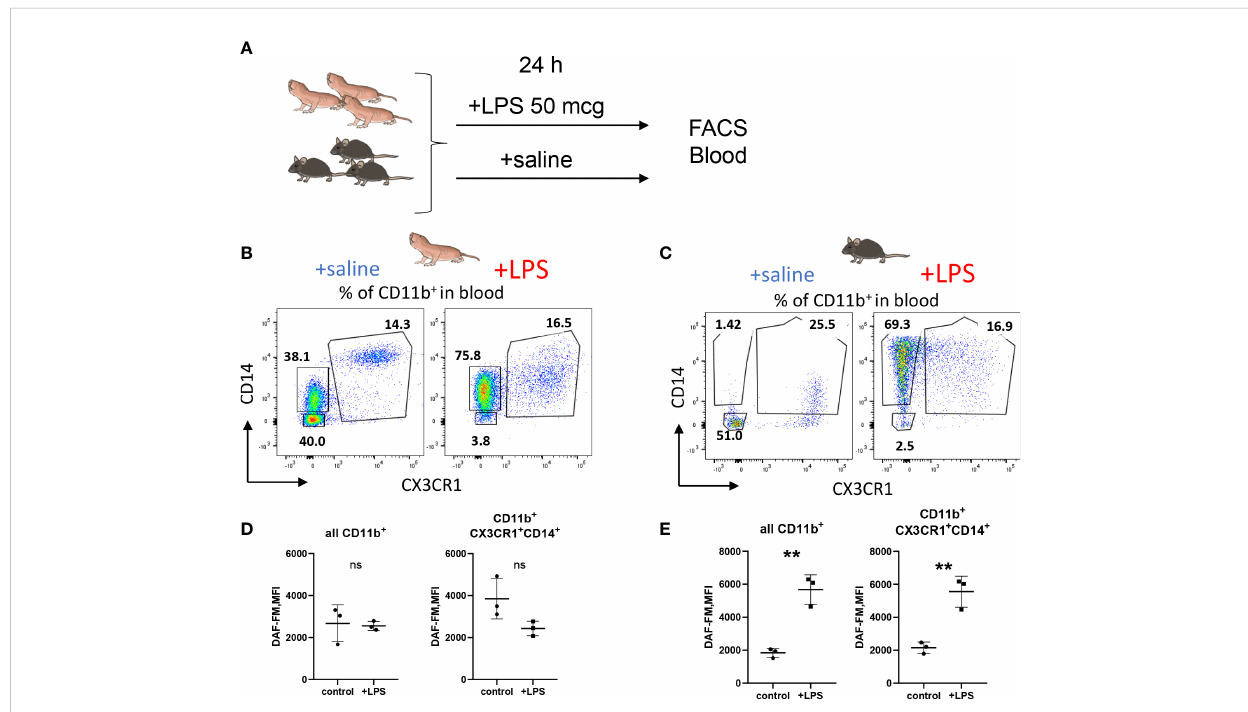
FIGURE 4 NO production is reduced in NMR myeloid cells after LPS administration in vivo. (A) Groups of animals (n ≥ 3) were subjected to LPS administration i.p. (50 mcg/20 g bodyweight), after 24 h peripheral blood was analyzed by FACS. Representative dot plots of NMR (B) and mouse (C) CD11b + blood cells distributed via CD14 and CX3CR1 surface expression in control and LPS groups. DAF-FM MFI measured in whole CD11b + blood population and in the population of CX3CR1-positive monocytes in NMR (D) and mouse (E) . Results displayed as mean MFI ± SD. **p<0.001; ns-not signi fi cant, Student ’ s